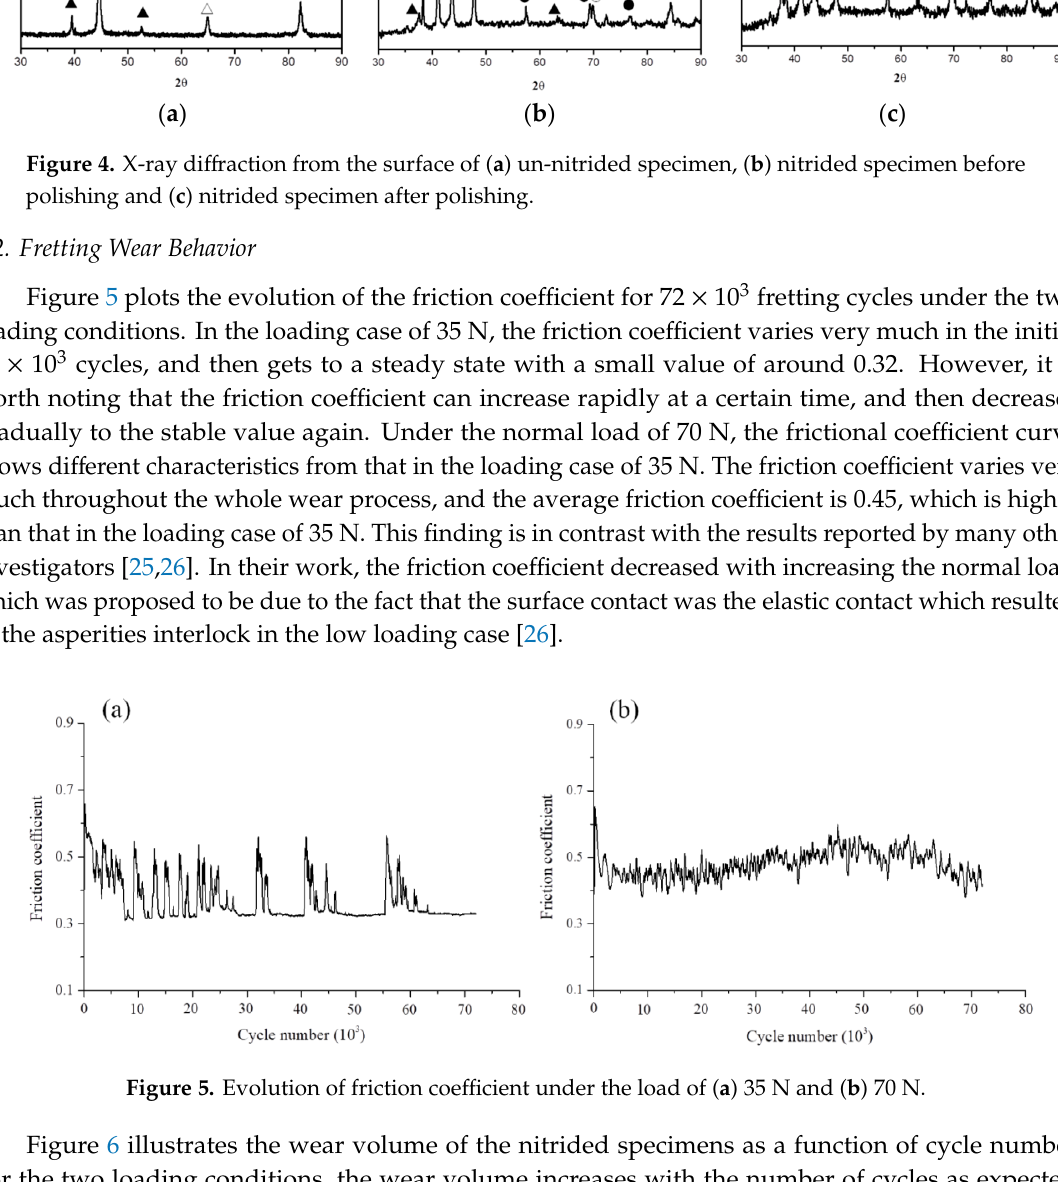
Figure 4. X-ray diffraction from the surface of ( a ) un-nitrided specimen, ( b ) nitrided specimen before polishing and ( c ) nitrided specimen after polishing.